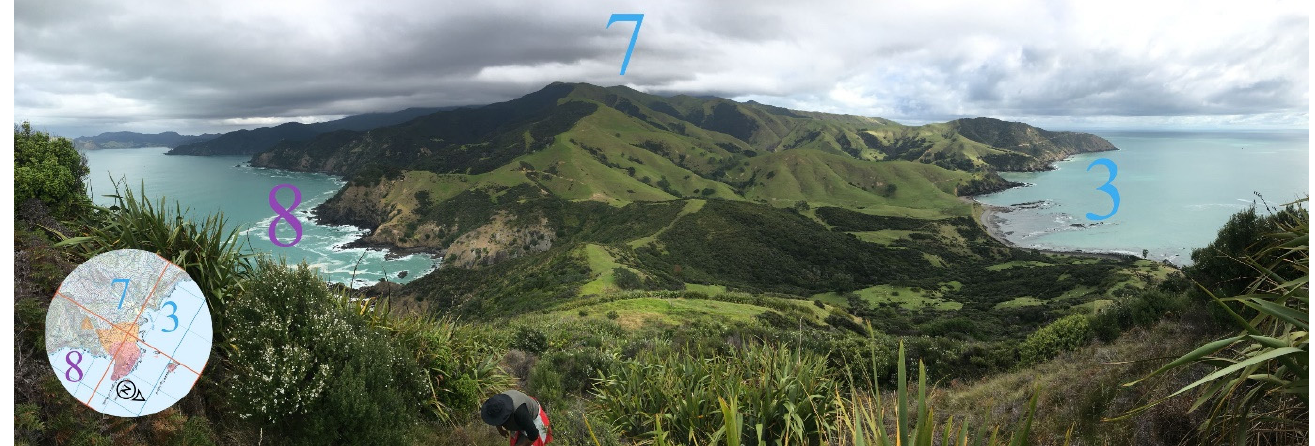
Figure 8. Landscape of Port Jackson, Fletcher Bay, and Port Charles districts (Coromandel Peninsula). The picture was taken from zone 4, which at an elevation of around 200 m allows viewing across to the neighboring zones 3, 7 and 8. Additionally, numbers are presented in colors according to their geodiversity final mark (Figure